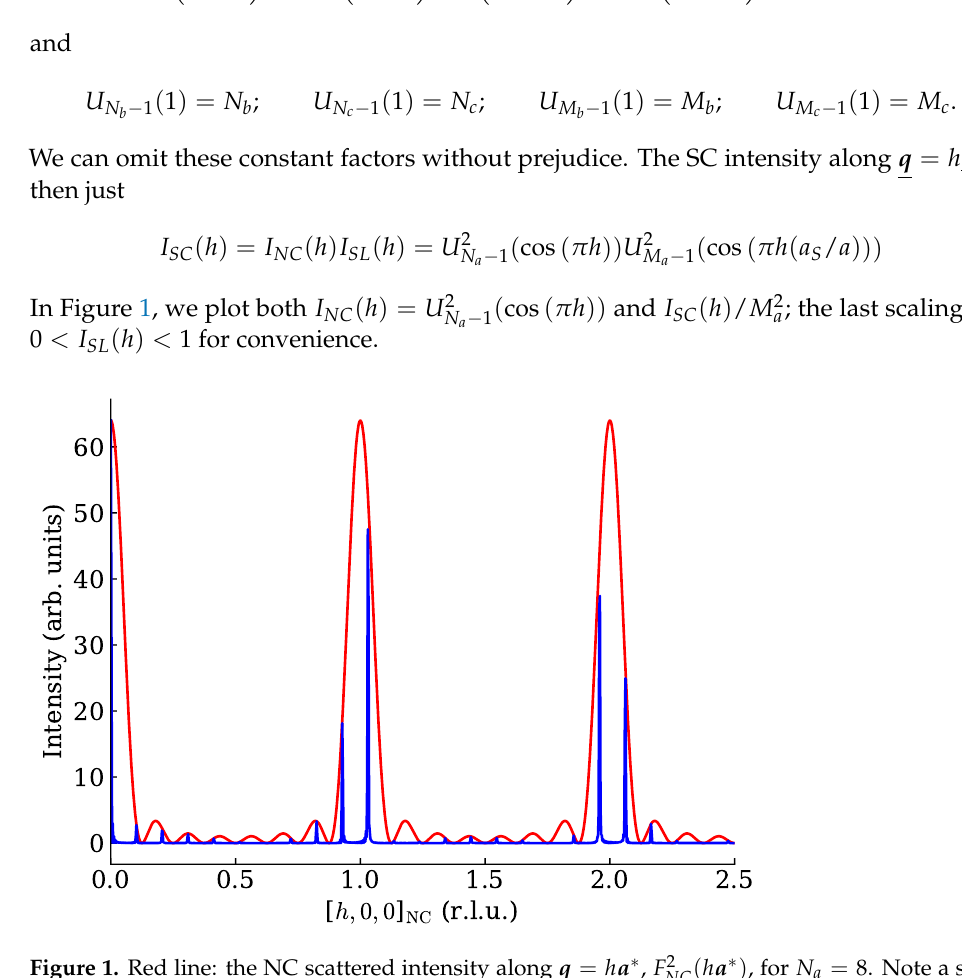
( h a ∗ ) , for N a = 8. Note a sharp Figure 1. Red line: the NC scattered intensity along q = h a ∗ , F 2 NC peak at all integer values of h , and the NC-suffix on the x -axis label indicates that the metric is defined by the NC lattice. The peaks have all the same shape and are bracketed by zeroes at h = k ± 1/ N a , k ∈ Z . Factors M b , M c Blue line: I SC ( q ) / M 2 a for N a = 8, M a = 20, a S = 9.7 a . One can clearly see the very sharp SL peaks modulated by the NC scattered intensity, so that each NC peak is replaced by a tight “copse” of sharper SL